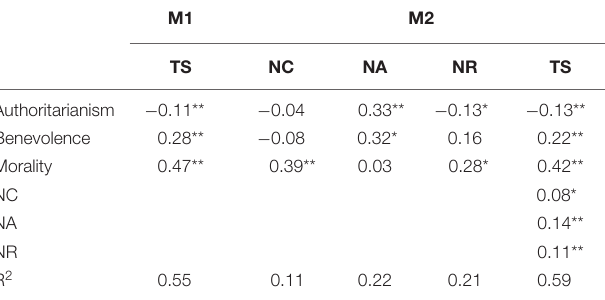
TABLE 3 | Standardized results of stepwise mediation test of basic psychological